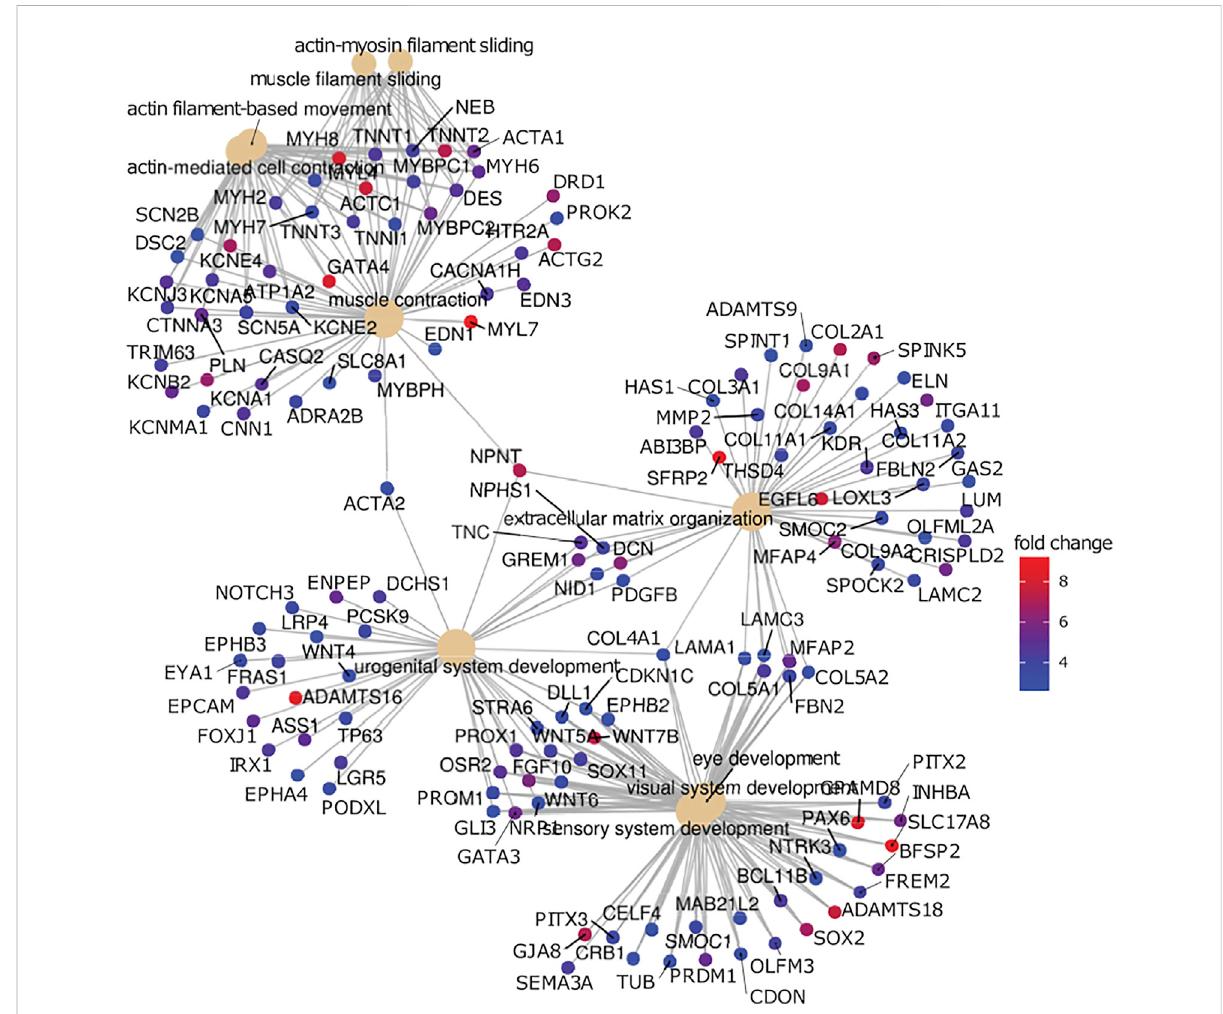
FIGURE 5 Gene network analysis comparison between RPE. Genes highly expressed in iPSC-RPE when compared to ahRPE are associated with neural differentiation,extracellularmatrixorganization,andmusclecontraction.GenesupregulatediniPSC-RPEversusahRPEwereanalyzedforfunctional roles by gene set enrichment analysis using gene ontology terms (GO). Plot represents the top 15 enriched categories with adjusted p -value < 0.05 and logFC > 2. Categories (GO terms) are plotted as beige nodes, and genes belonging to the respective terms are colored by expression fold change between the